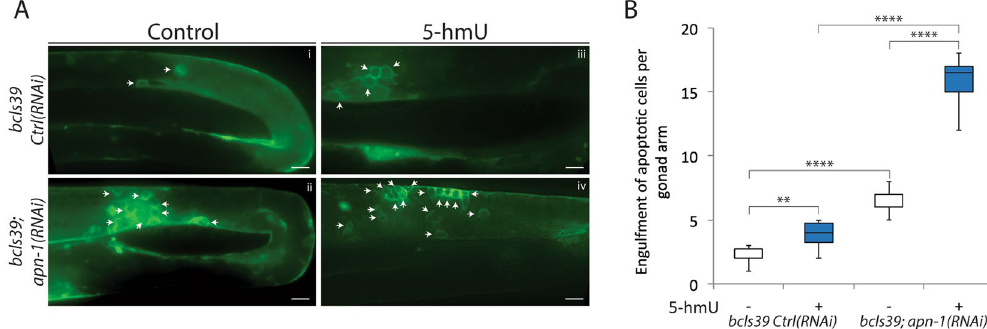
Figure 4. 5-hmU induces CED-1 engulfment of apoptotic germ cells. ( A ) Representative images of control and 5-hmU-treated bcls39 [CED-1::GFP] worms. The ring around the apoptotic corpses indicates the engulfment of apoptotic bodies shown by white arrows. Scale bar = 10 μ m. ( B ) Box and whisker plots showing quantification of the engulfment of apoptotic